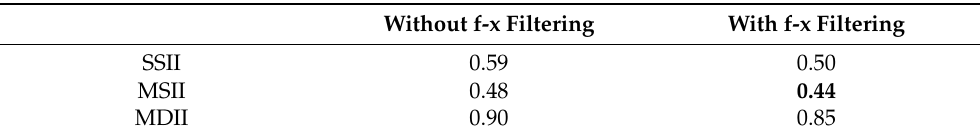
Table 1. The RMSE of the inversion results (Marmousi model) of SSII, MSII and MDII combined with and without f-x